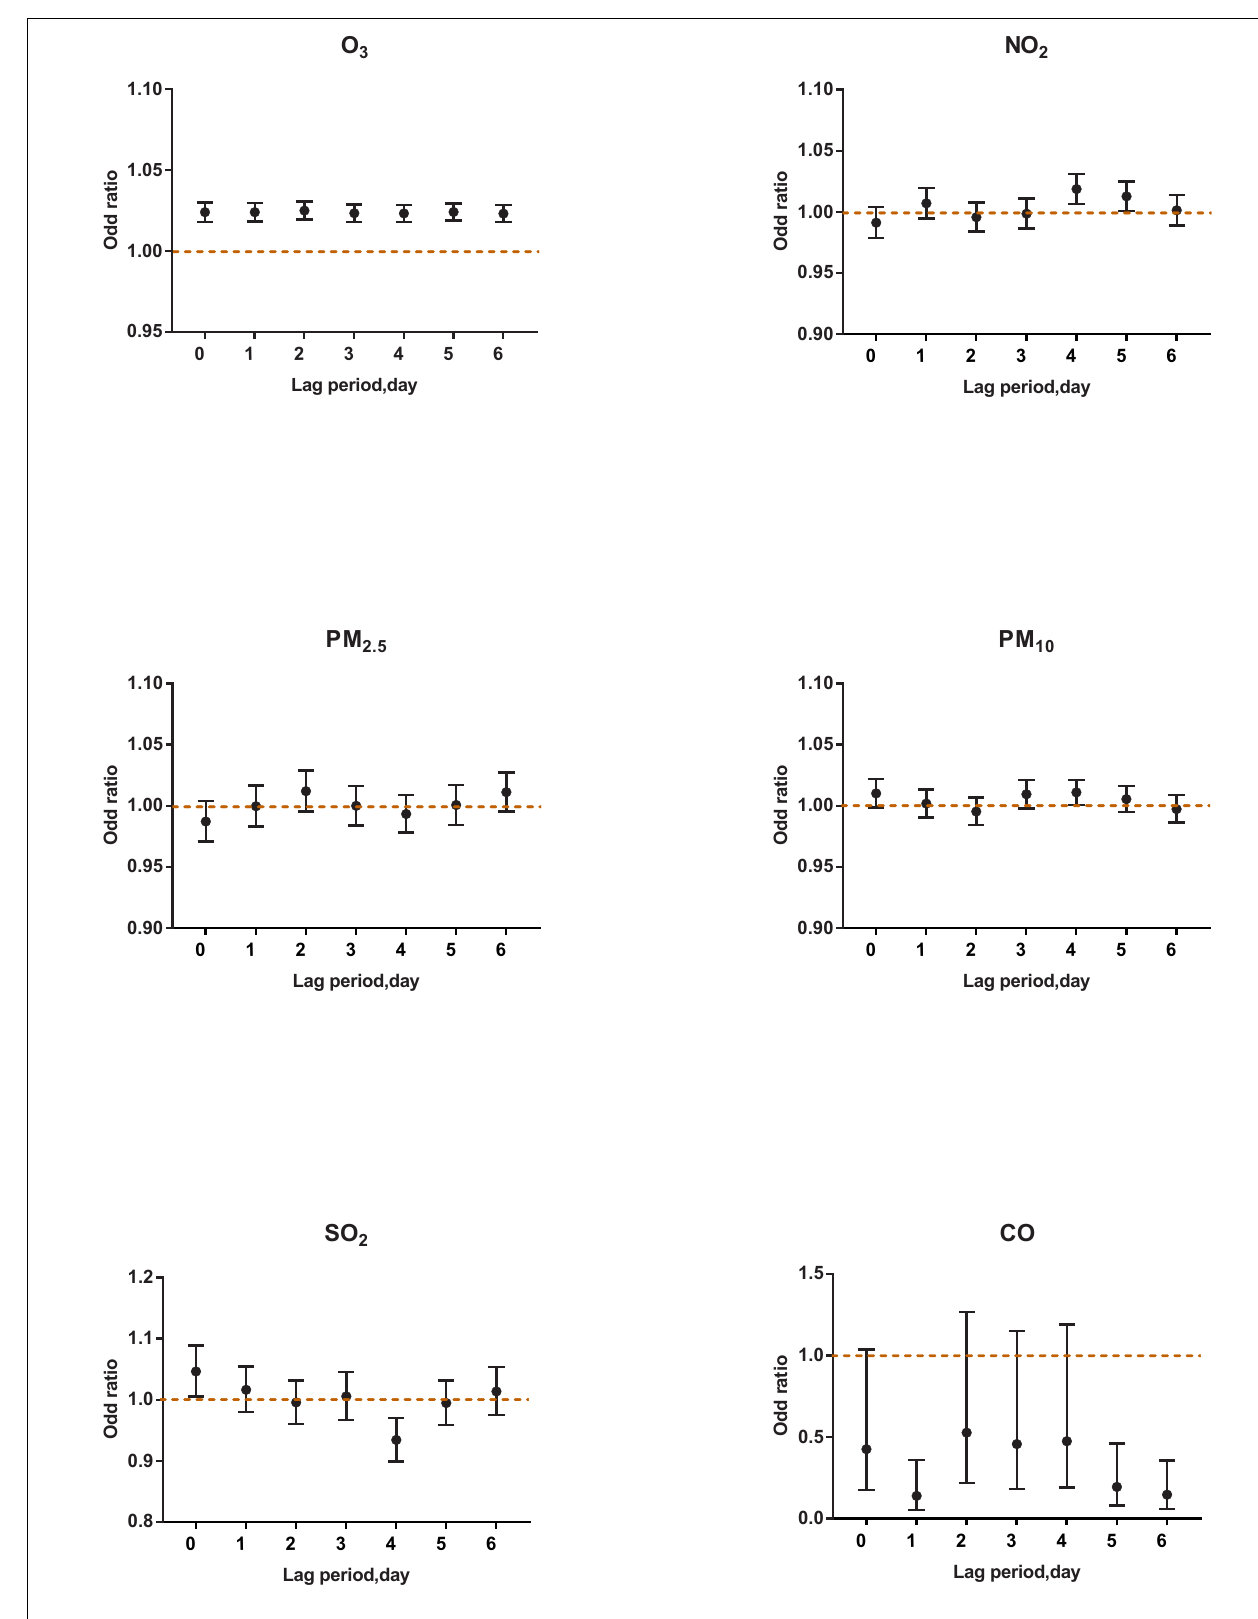
Frontiers in Pediatrics |